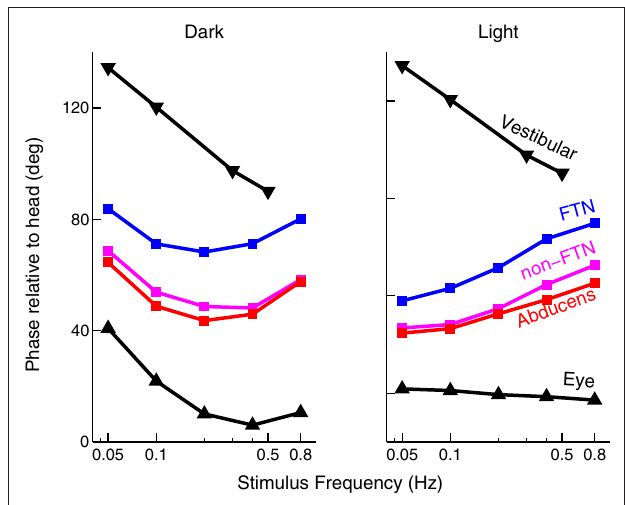
FIGURE 6 | Timing of activity of FTNs in the VN, compared to non-FTNs, Abducens nucleus, vestibular efferents, and the actual eye movement. All phases are given with respect to a vestibular stimulus that was either given in the dark (left panel), or in the light (right panel). Data from Stahl and Simpson (1995).